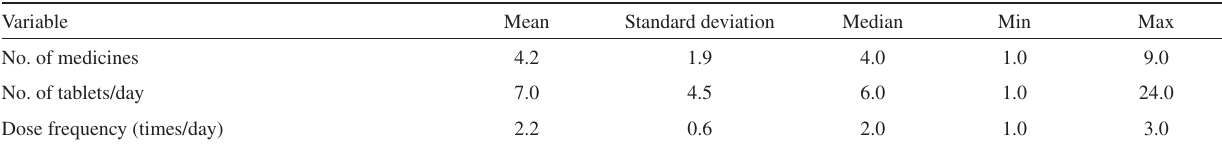
Table 6 - Descriptive values of medicines prescribed to the 75 included patients Variable